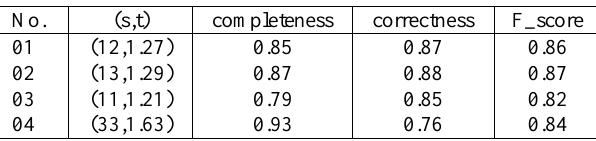
Table 11.Evaluation of extracted marking of samples.